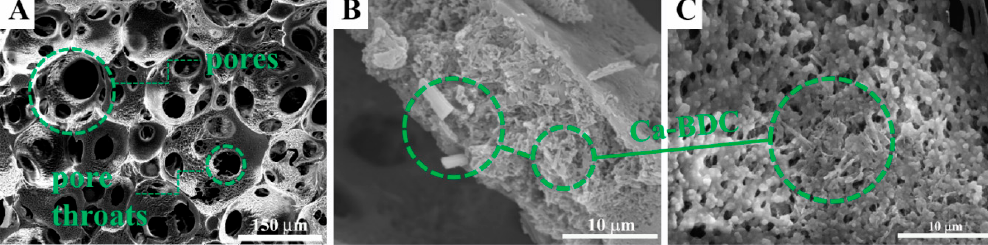
Figure 2. The pore structures and Ca-BDC distribution in ( A ) Ca-BDC / polyHIPEs: ( B ) and ( C ) are the cross-sectional view and surface of the pore of Ca-BDC / polyHIPEs, respectively, and Ca-BDC particles were marked with circles. Polymers 2020 , 12 , x FOR PEER REVIEW